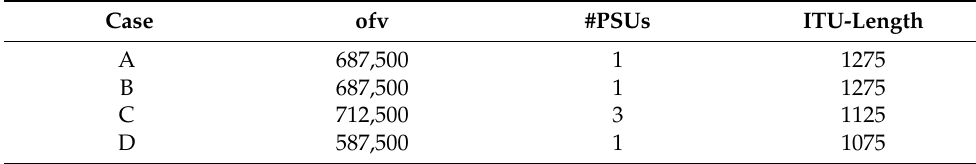
Table 4. Effects of multiple vehicle types in the Fictitious Airport